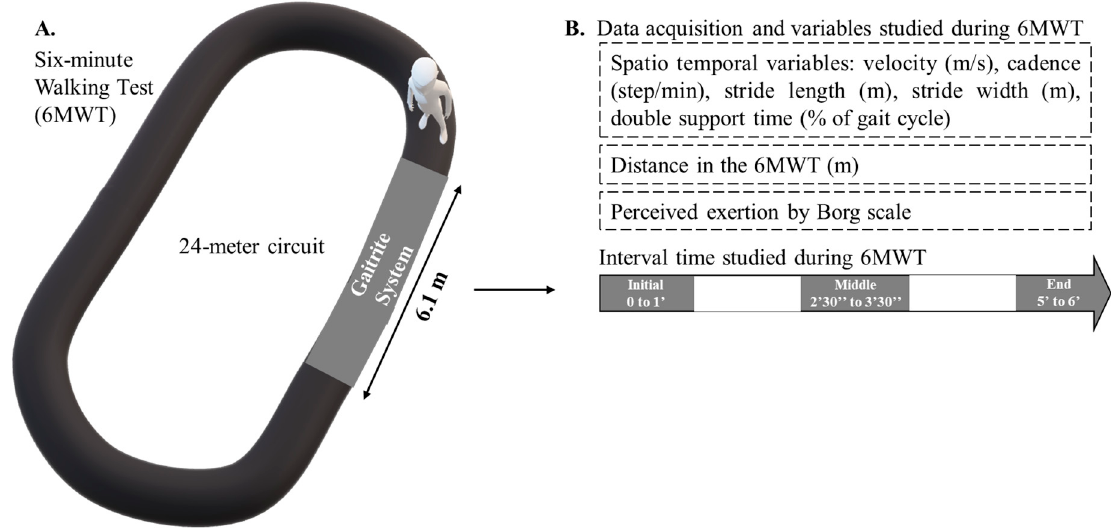
Figure 1. ( A ) gait evaluation during the six-minute walk test (6MWT); ( B ) variables studied during each interval of the 6MWT [25].